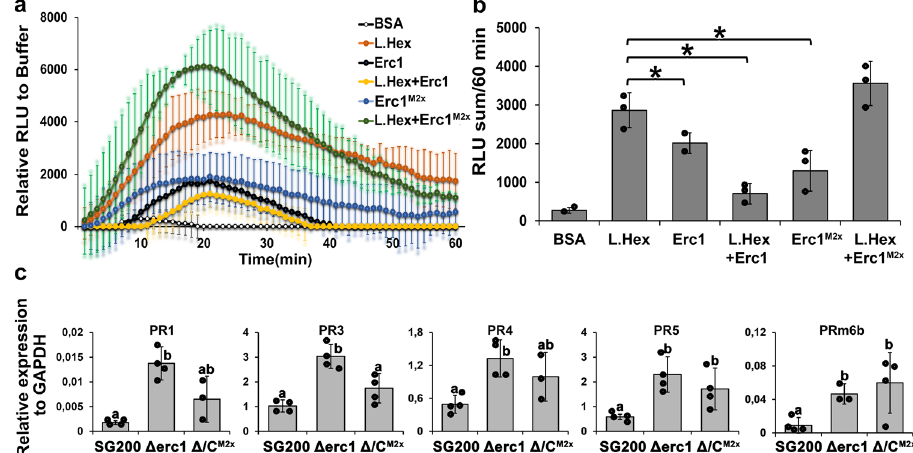
Fig. 5 | Smut Erc1 prevents induction of host defenses. a A ROS-burst assay was performed with barley leaf disks following incubation with laminarihexaose, Erc1, Erc1 M2x ,andamixoflaminarihexaoseandErc1recombinantproteins.BSAwasused as a negative control for background signal. Relative luminescence units (RLU) indicateROSburstactivityoftreatedbarleyleafdiscs.TheRLUarenormalizedwith the buffer control. Each curve shows the mean of at least nine technical leaf discs with three independent biological experiments. Data are presented as mean value±SD. b Statistical analysis was performed with sum of RLU values of each